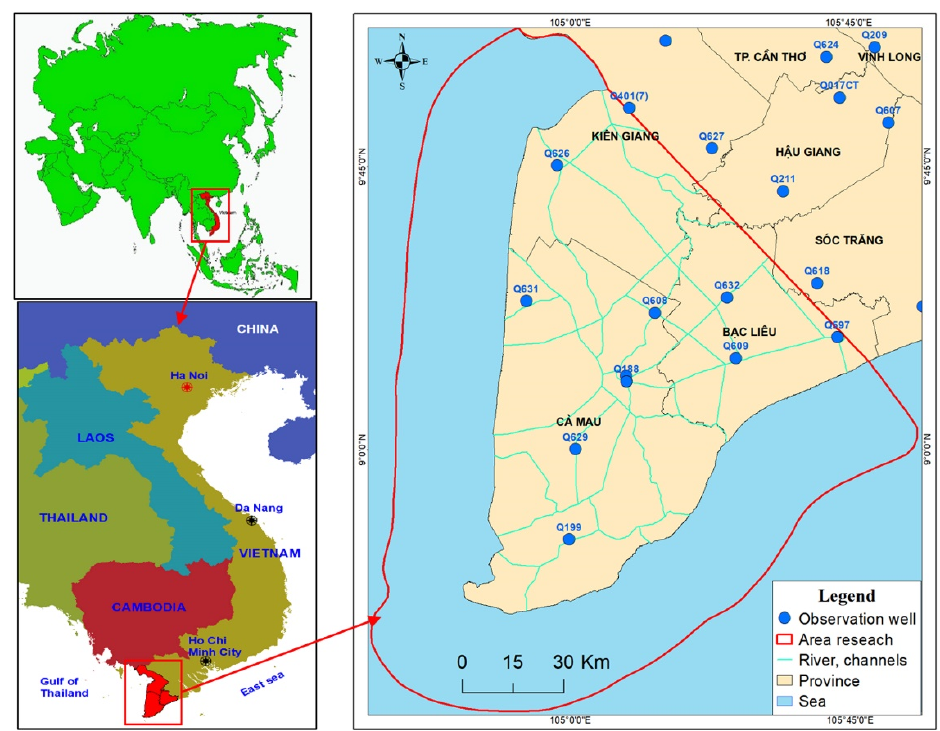
Figure 1. Location of the study area in the Ca Mau peninsula (sources of data: MONRE, NAWAPI, Esri, HERE, Garmin, © OpenStreetMap contributors, and the GIS user community).